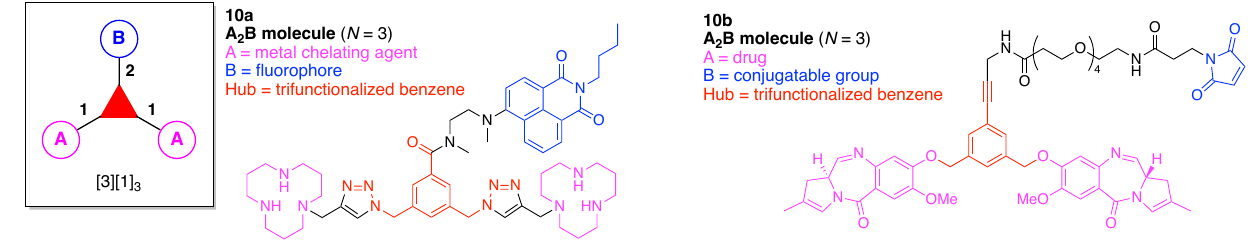
Figure 42. Examples wherein each contains a single benzene hub.